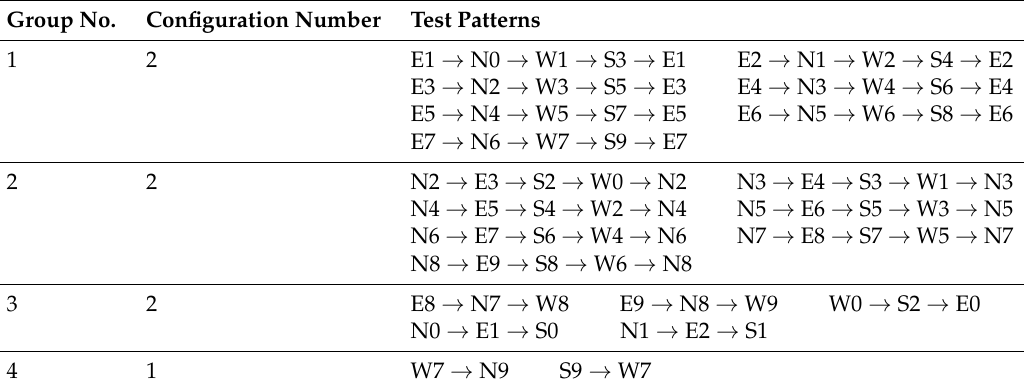
Figure 20. Four sets of partial-cascade patterns. Table 4. Test patterns in the oblique direction in one XC4VLX60